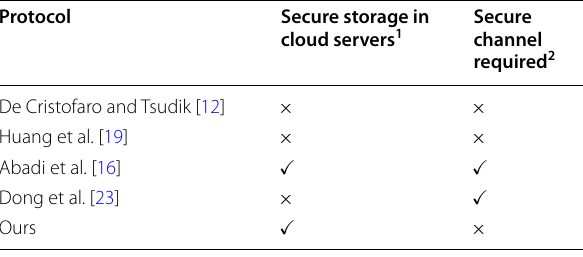
Table 3 Security function comparison among existing protocols